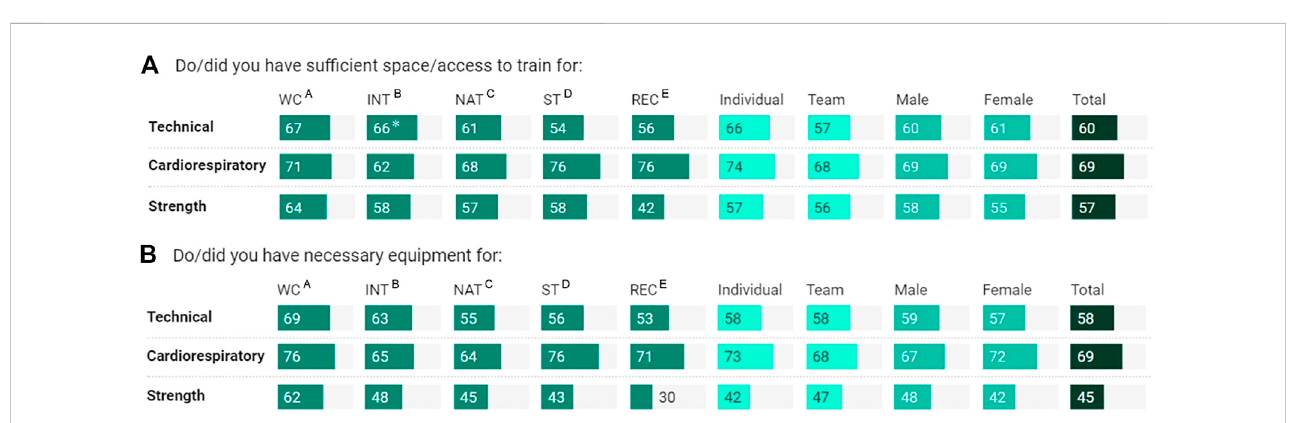
FIGURE 4 Training space/access (A) and equipment (B) for technical, cardiorespiratory, and strength by athlete classi fi cation, sport-type, gender, and total cohort ( n = 660). Percentage, within athlete classi fi cation, sport-type, and gender, represents “ yes ” answer, relative to “ no ” answer. WC, world-class;